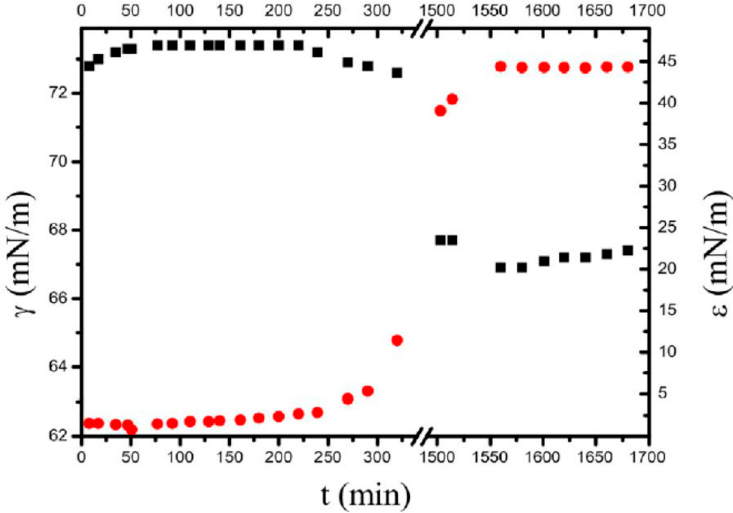
Figure 13. The kinetic dependencies of the surface tension (black squares) and dynamic surface elasticity (red circles) of C60-lysine solutions at the concentration of 0.5 g/dm³; taken from [125].